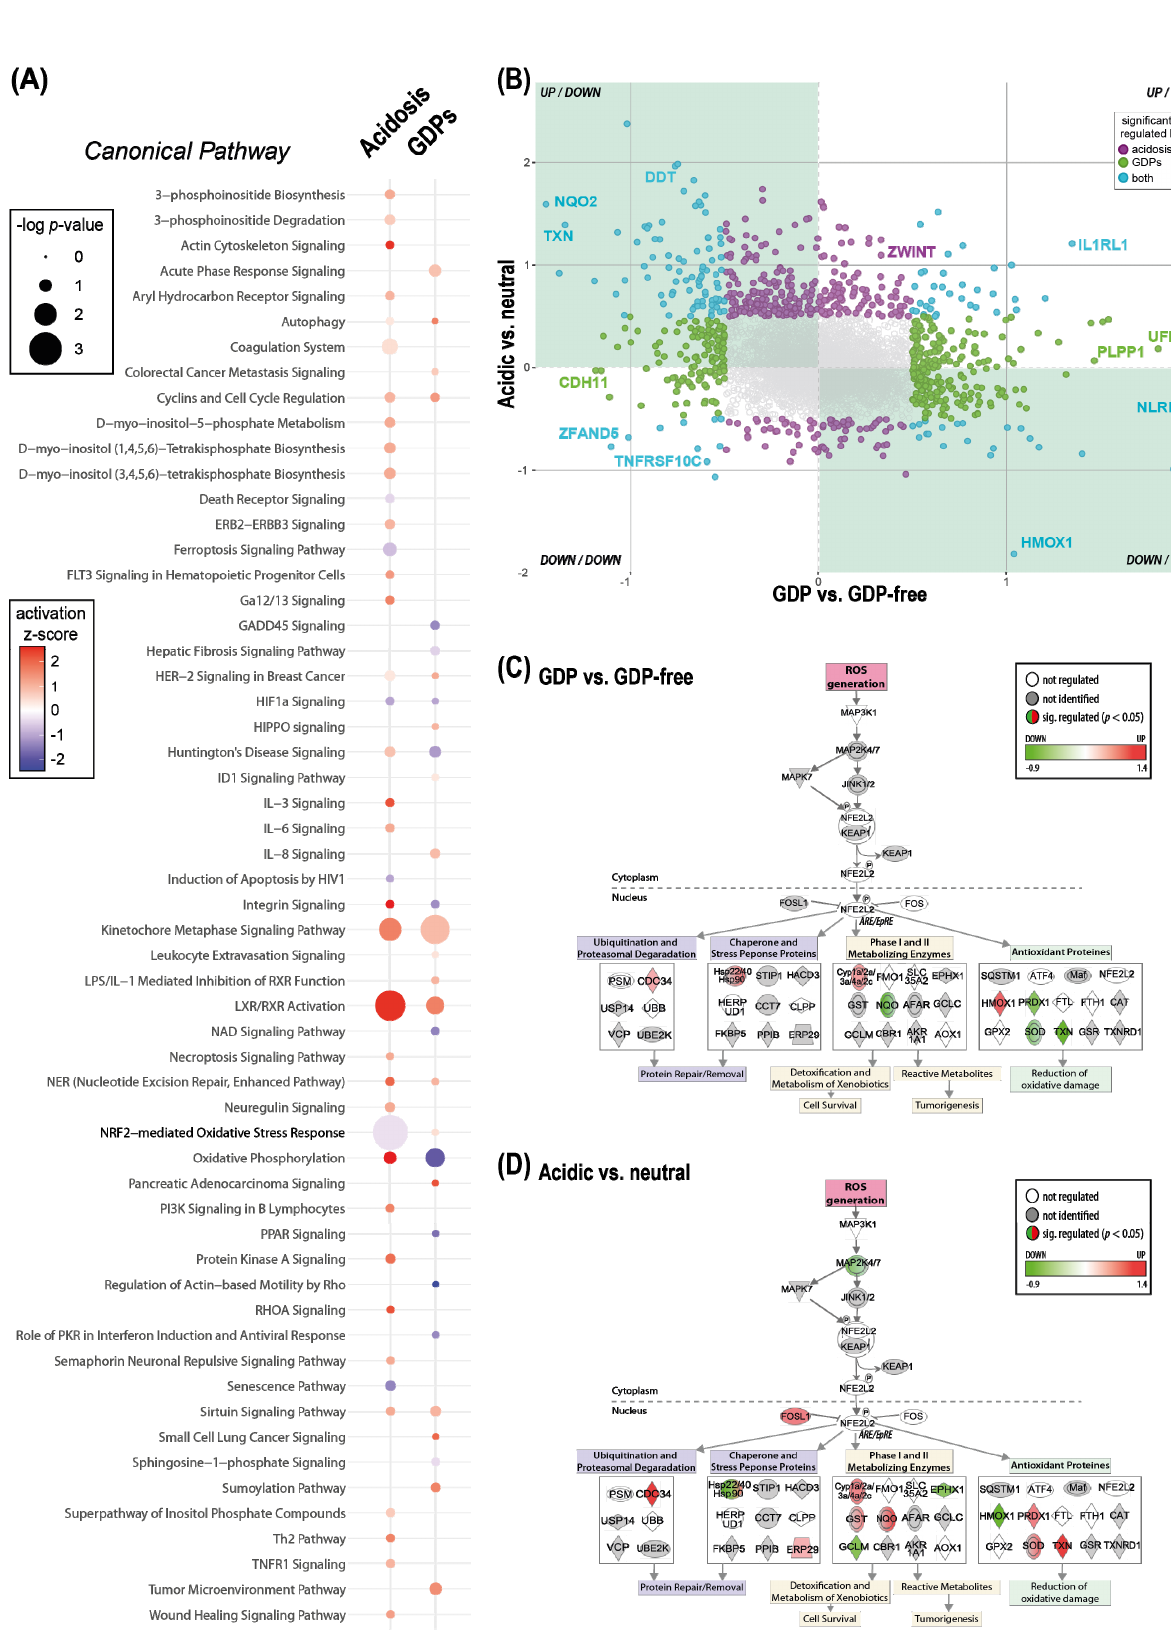
Figure 4. Effects of acidic pH or presence of glucose degradation products (GDPs) in PD fluids on endothelial cells. ( A ) Significant IPA canonical pathways (Fisher’s exact test p < 0.05) with an activation z-score ≠ 0; modeled acidosis effect: single-chamber, icodextrin, and filter versus double-chamber PD fluid; modeled GDPs effect: single-chamber, double-chamber, and icodextrin versus filter PD fluid; size of the nodes indicates the p -value of enrichment of the pathway. The activation